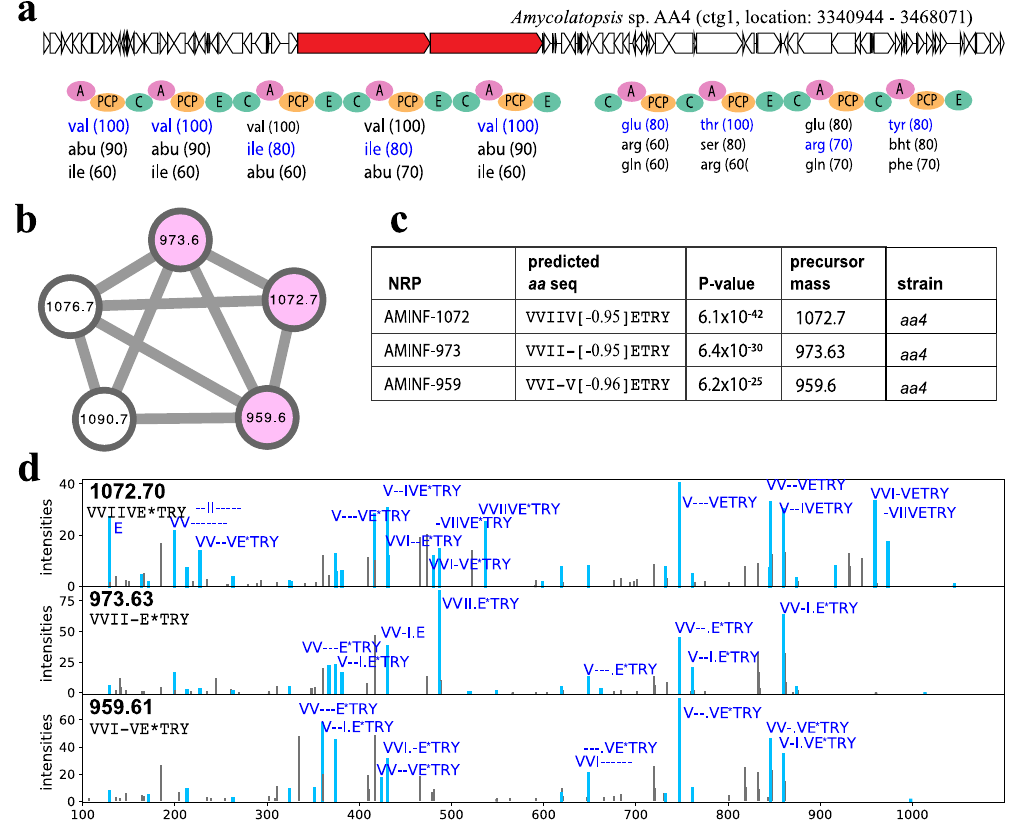
Fig. 6 Identifying aminformatide (AMINF) NRP family discovered by NRPminer in the SoilActi dataset. a The BGC generating the core NRP in Amycolatopsis sp. AA4 along with NRPS genes (shown in red) and the A-, C-, PCP, and E-domains appearing in the corresponding NRPS. The rest of the genes in the corresponding contigs are shown in white. Three highest-scoring amino acids for each A-domain in this BGC (according to NRPSpredictor2 (ref. 15 ) predictions) are shown below the corresponding A-domains. Amino acids appearing in the NRP VVIVETRY identi fi ed by NRPminer (with the lowest p value) are shown in blue. b Spectral network formed by spectra that originate from the AMINF NRPs. A node is colored if the corresponding spectrum forms a statistically signi fi cant PSM and not colored otherwise. The p values are computed based on MCMC approach using MS-DPR 89 with 10,000 simulations. c Sequences of the NRPs identi fi ed by NRPminer in the aminformatide family (with the lowest p value among all PSMs originating from the same NRP). NRPminer predicted a PAM with loss of ~0.96 Da on E, represented by E*. AMINF represents aminformatide. d For each identi fi ed NRP, an annotated spectrum representing the lowest p value is